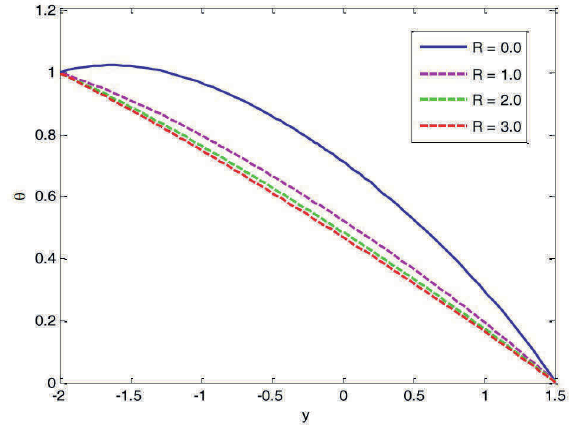
Fig. 19: Impact of heterogeneous reaction parameter K s on concen- tration.